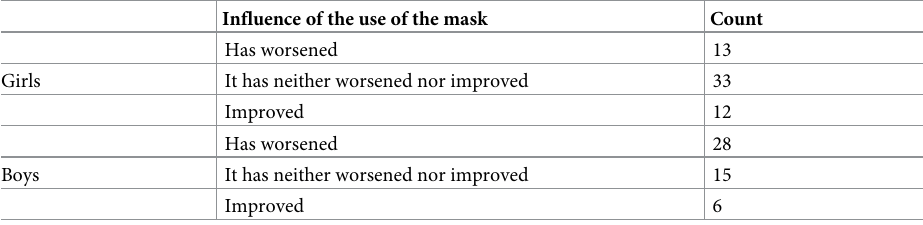
Table 1. Influence of the pandemic on academic performance. Influence of the use of the mask Count Has worsened 13 Girls It has neither worsened nor improved 33 Improved 12 Has worsened 28 Boys It has neither worsened nor improved 15 Improved 6 Note. Correlation p = 0.01 following Kendall’s tau b